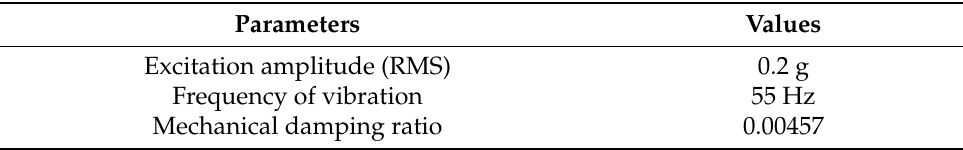
Table 2. Vibration conditions used as excitation of the energy